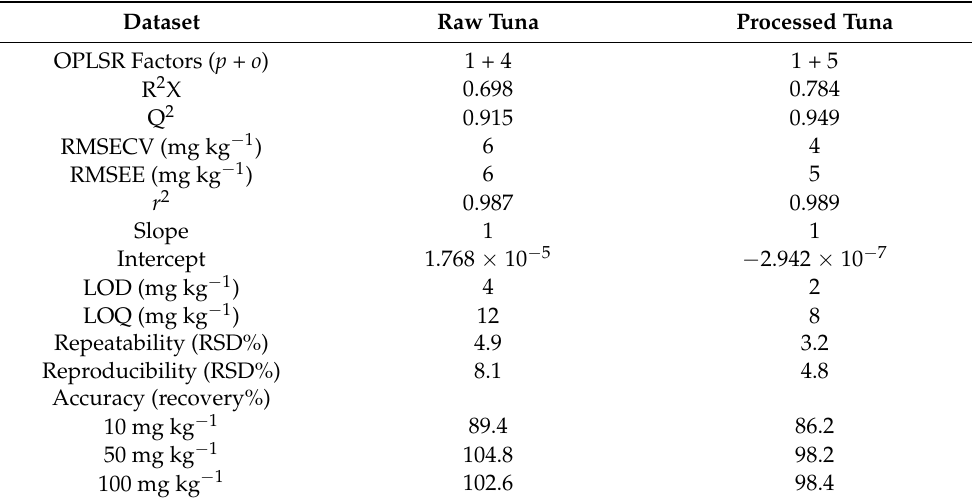
Table 1. Main quantitative and qualitative (discriminant) applications of NIR spectroscopy to different fish and seafood